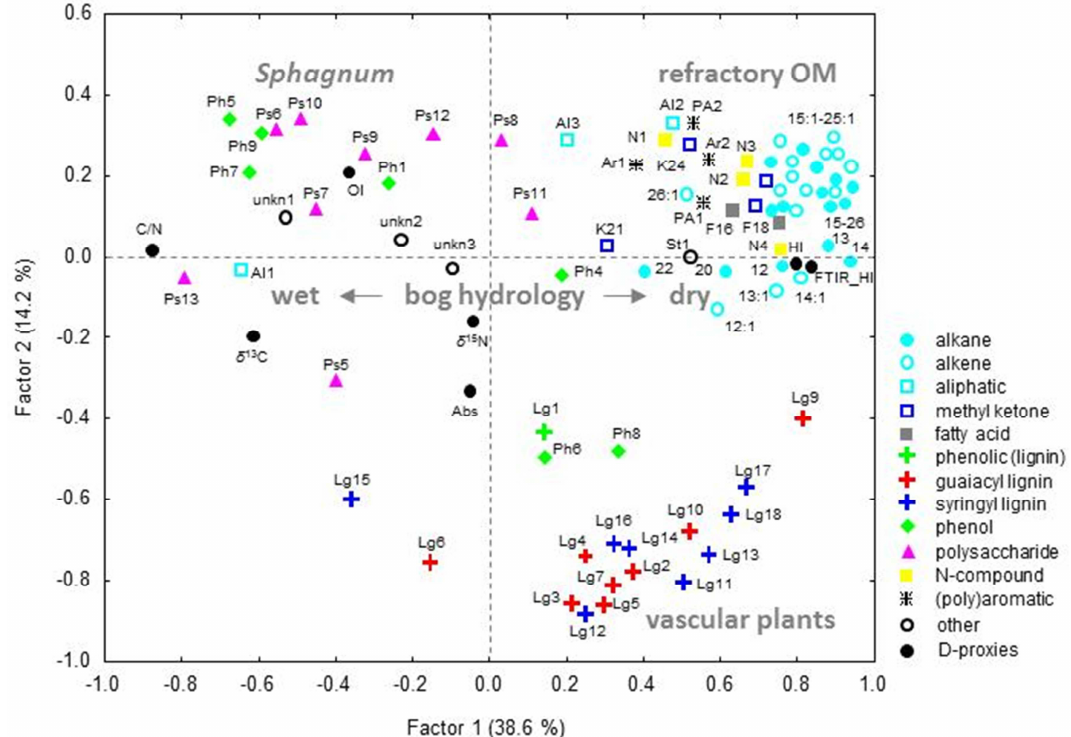
Figure 4. Factor loadings of the F1–F2 projection extracted from PCA of pyrolysis products from peat samples of the KK core. Note the opposite loadings of polysaccharides versus alkanes, alkenes and aliphatics on F1, while lignins have high loadings on F1 and F2 resulting in “fields” separating Sphagnum moss from vascular plants and refractory OM. Thus, the projection of F1–F2 factor loadings could help to separate decomposition and vegetation effects.